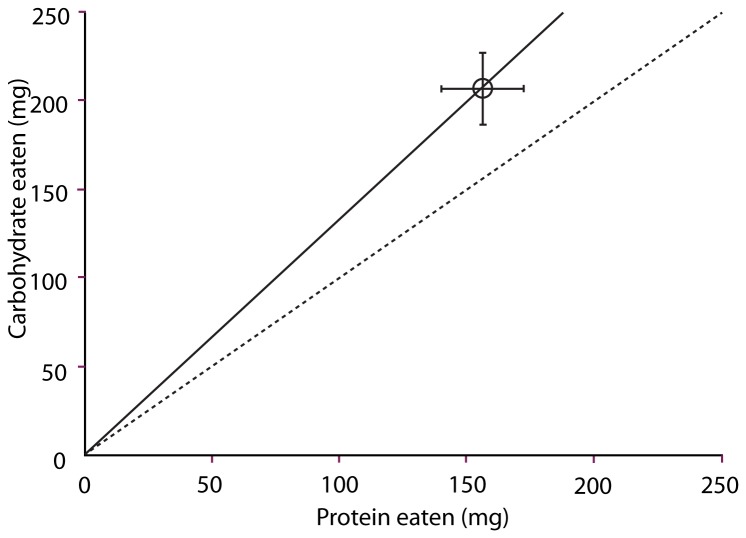
Mean amount of artificial food eaten by Hemideina crassidens individuals over a seven night experimental trial period (x ± SE).Weta selected foods non-randomly so that carbohydrate consumption was greater than protein on average. Dotted line indicates a 1:1 ratio.